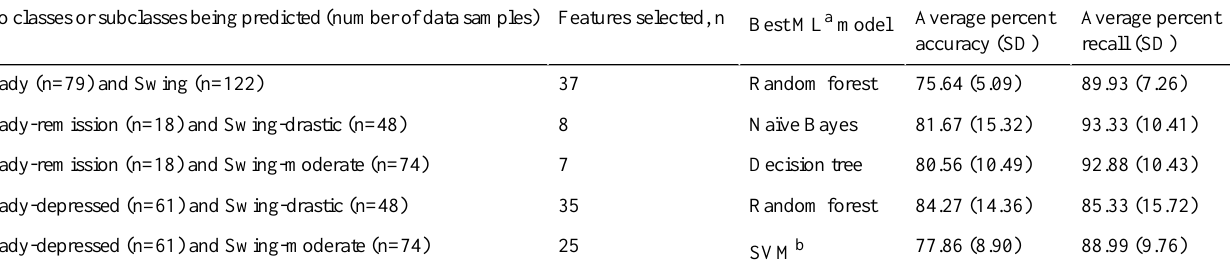
Table 8. Classification result using selected features of call logs, sleep data, step count data, and heart rate data.